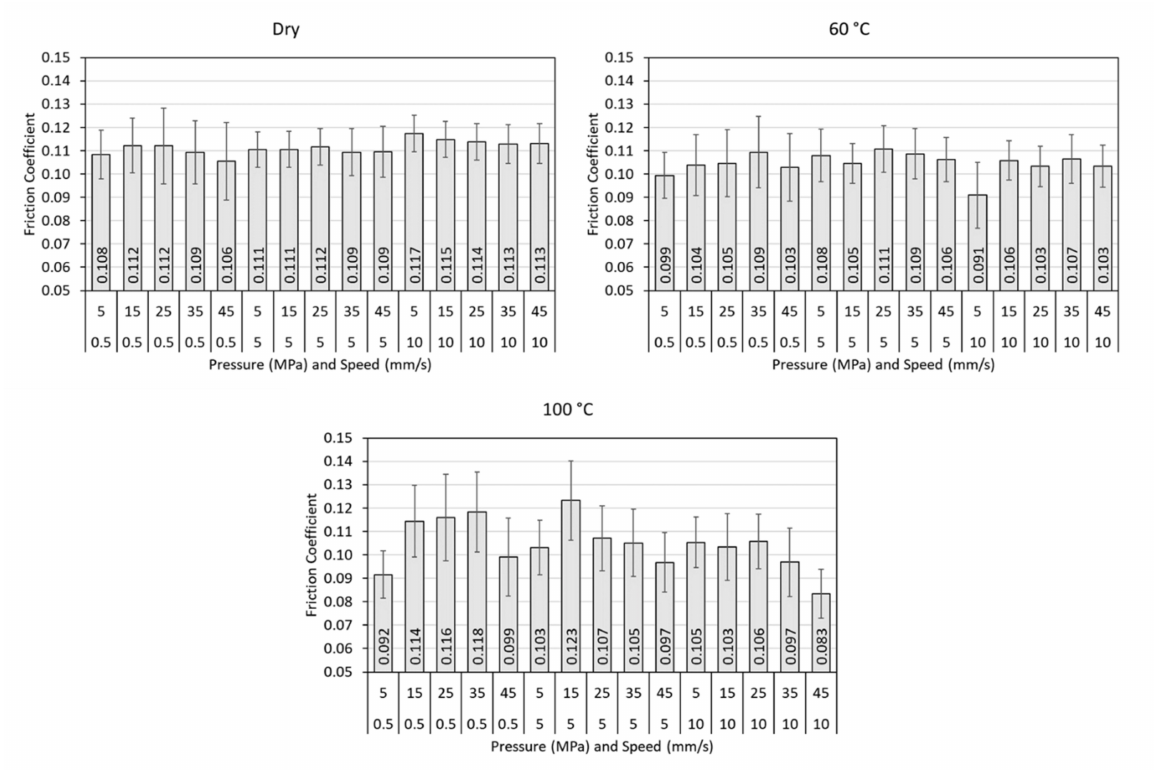
Figure 5. Tribology test for conditions at dry room temperature together with a temperature of 60 ◦ C and 100 ◦ C.